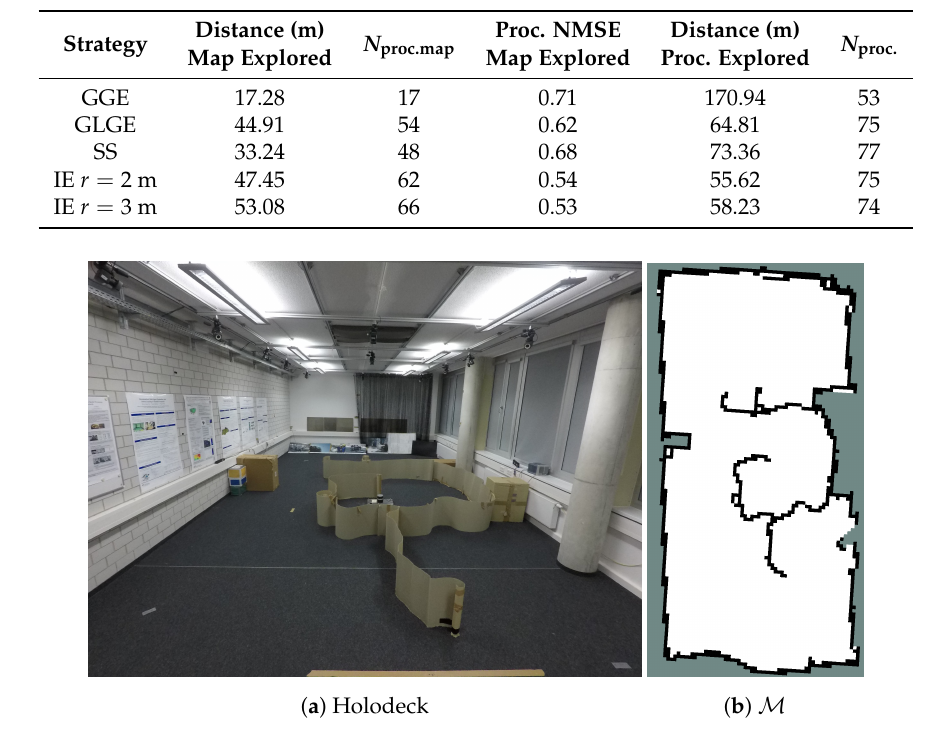
Table 9. Experiment E1: (i) mapping: Total travelled distance needed to explore the map with accompanied number of obtained process measurements up to that point N proc.,map and process NMSE; (ii) process exploration: Total exploration distance to explore the process and number of collected measurements ( N proc. ) required to achieve NMSE of 0.34 with respect to ground truth.